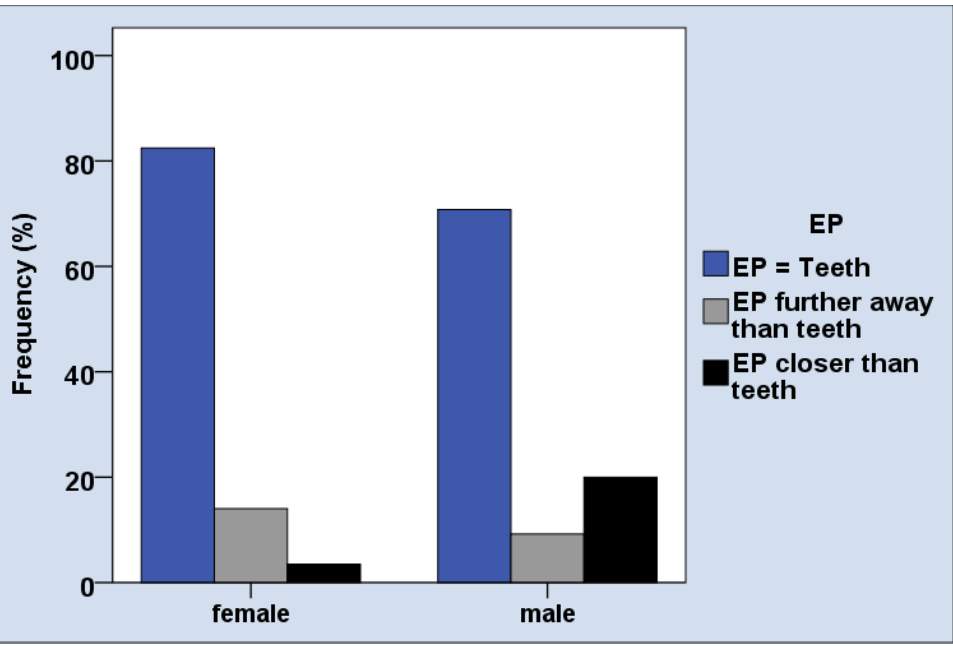
Figure 4. Gender difference in perceiving the relationship between EP and teeth in the PRISM task.